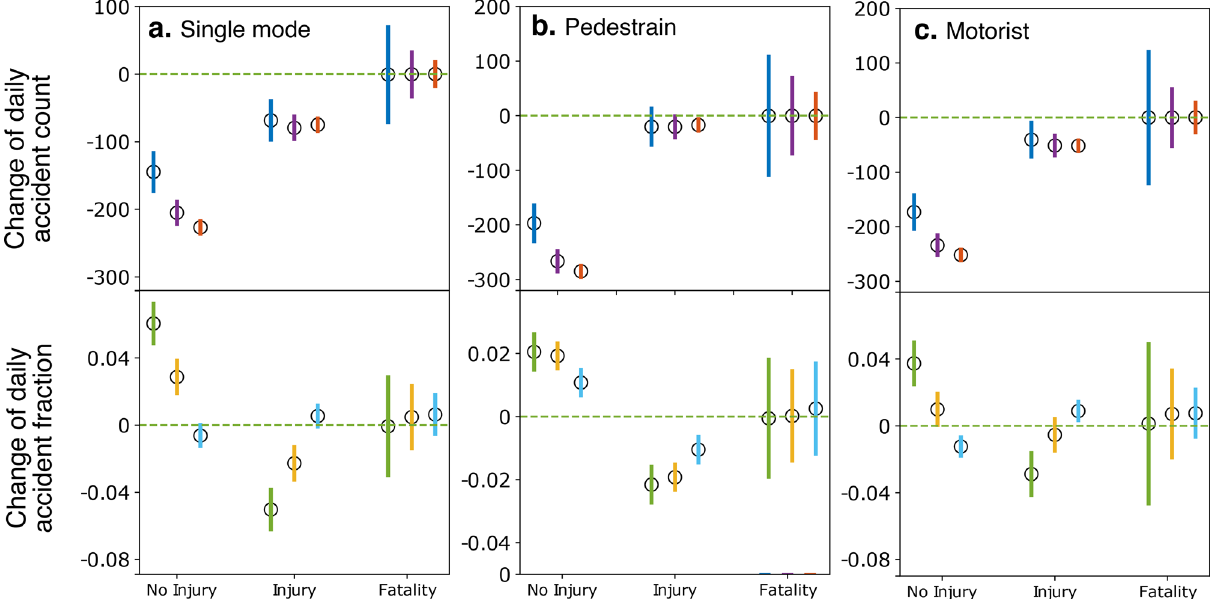
Figure 4. Change of daily accidents in NYC after the mobility change for different severity levels: no injury, injury, and fatality. The accidents are divided into three types: ( a ) not involving other transportation modes, ( b ) involving pedestrians, and ( c ) involving motorists. 95% confidence intervals are shown as vertical bars for each data point. Also shown are estimates from three time windows: 15 days (blue and green), 30 days (purple and orange), and 60 days (red and cyan) before and after the mobility change-point.